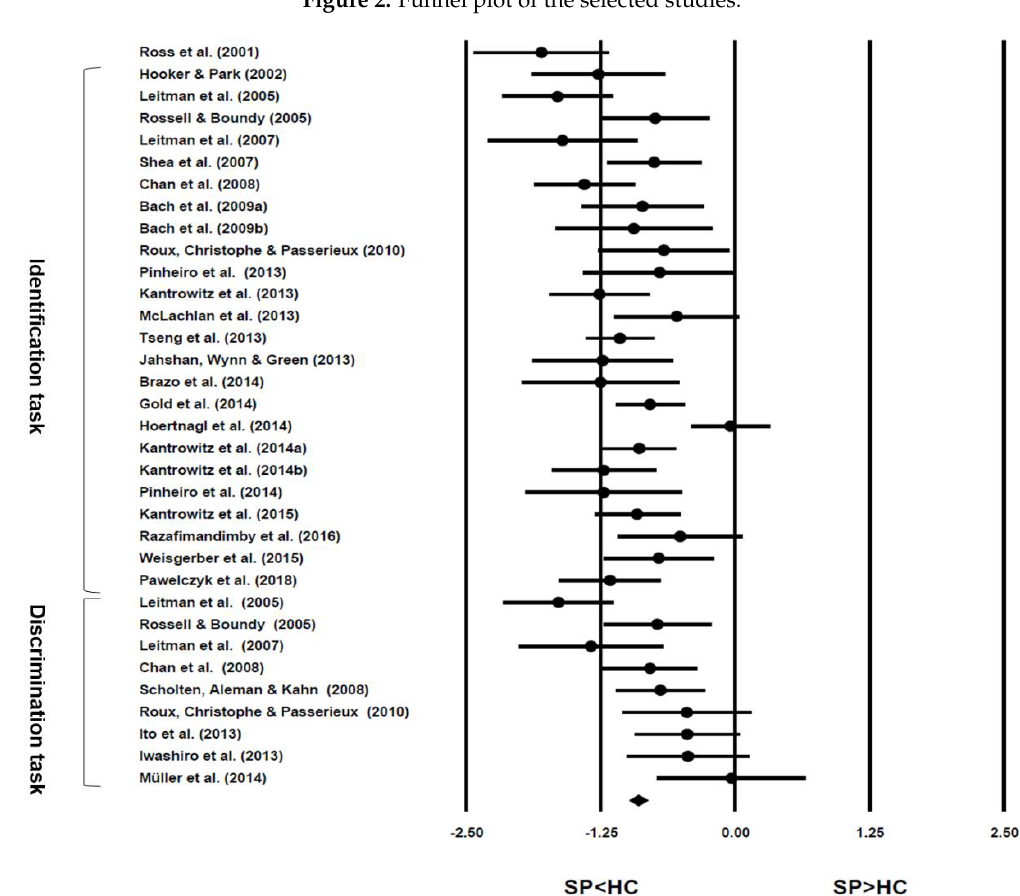
Figure 2. Funnel plot of the selected studies.